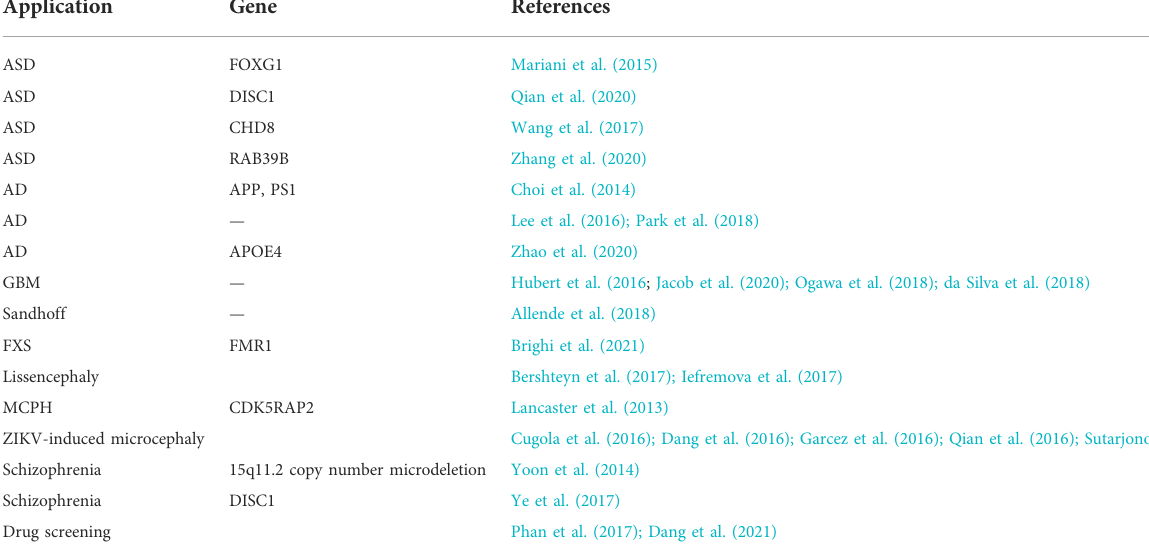
TABLE 1 Application of brain organoids: diseases modelling and drug